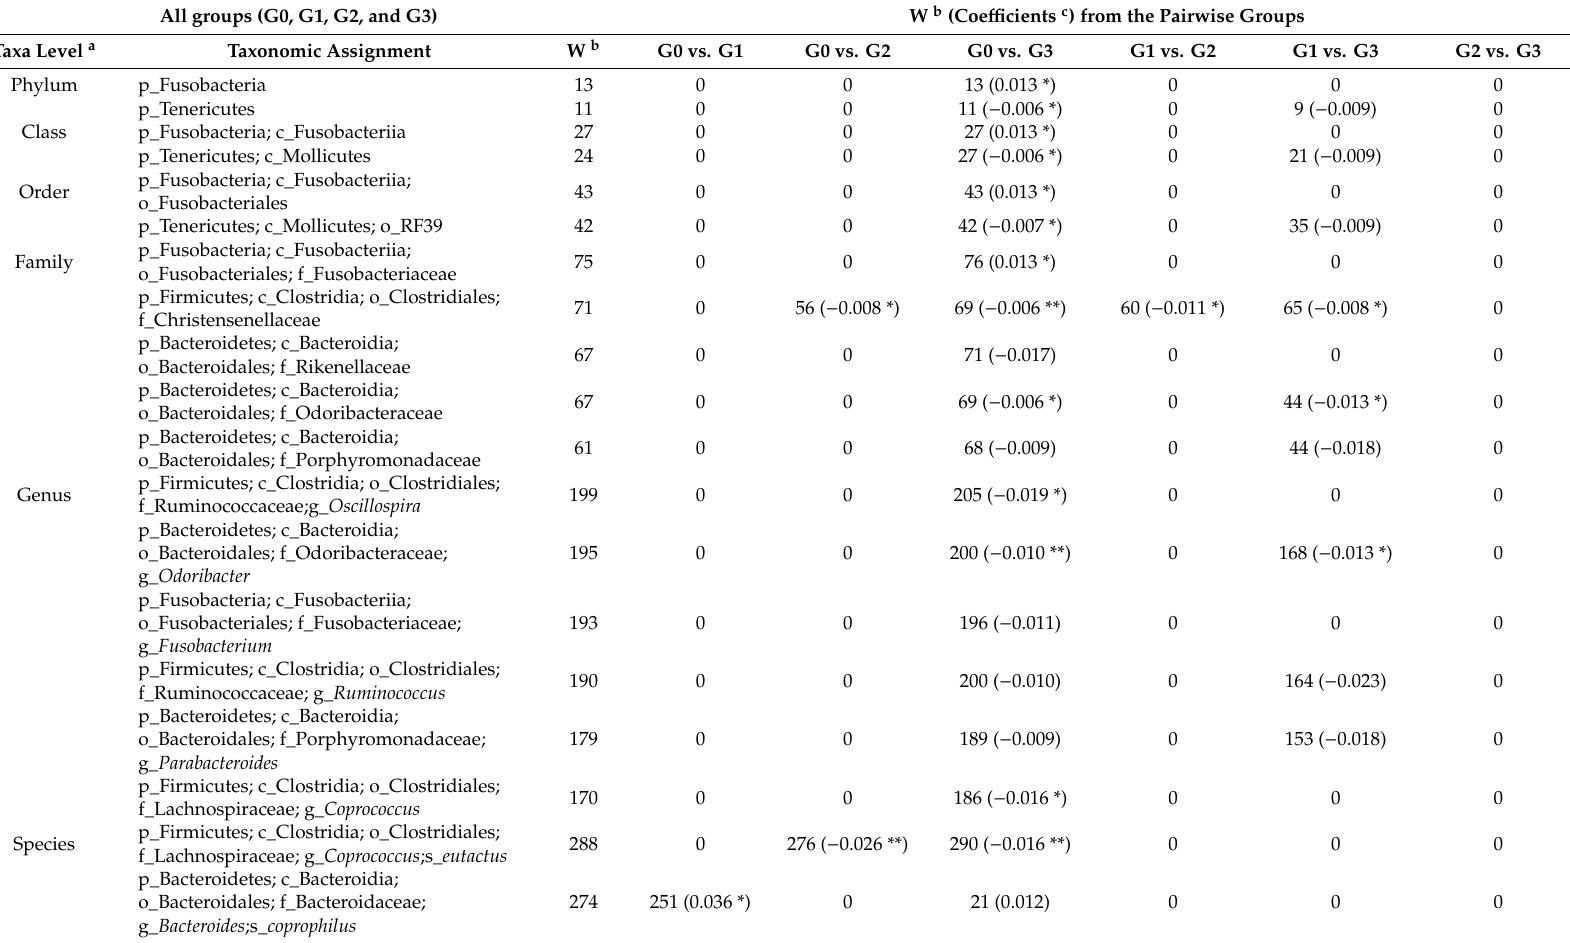
Table 2. Detection of di ff erentially abundant taxa among groups for the fatty liver persistence. All groups (G0, G1, G2, and